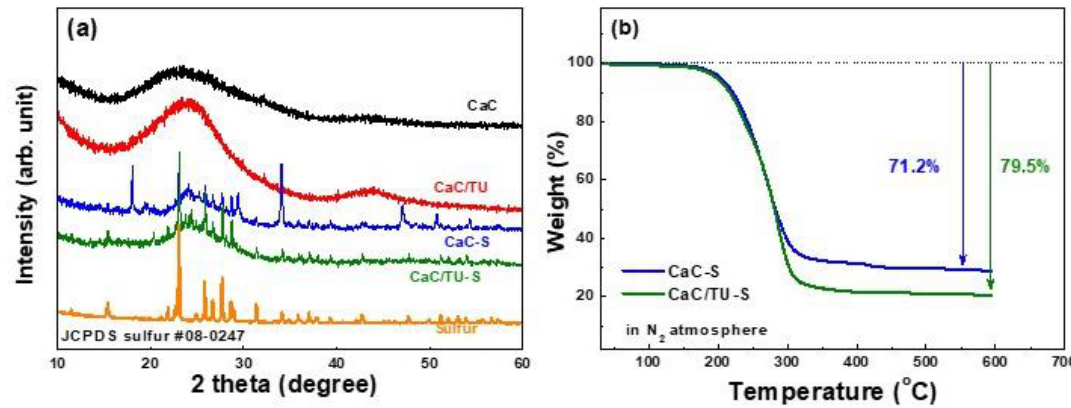
Figure 5. ( a ) XRD patterns of elemental sulfur, the CaC, CaC / TU, CaC-S, and CaC / TU-S powders. ( b ) TGA profiles of the CaC-S and CaC / TU-S powders.